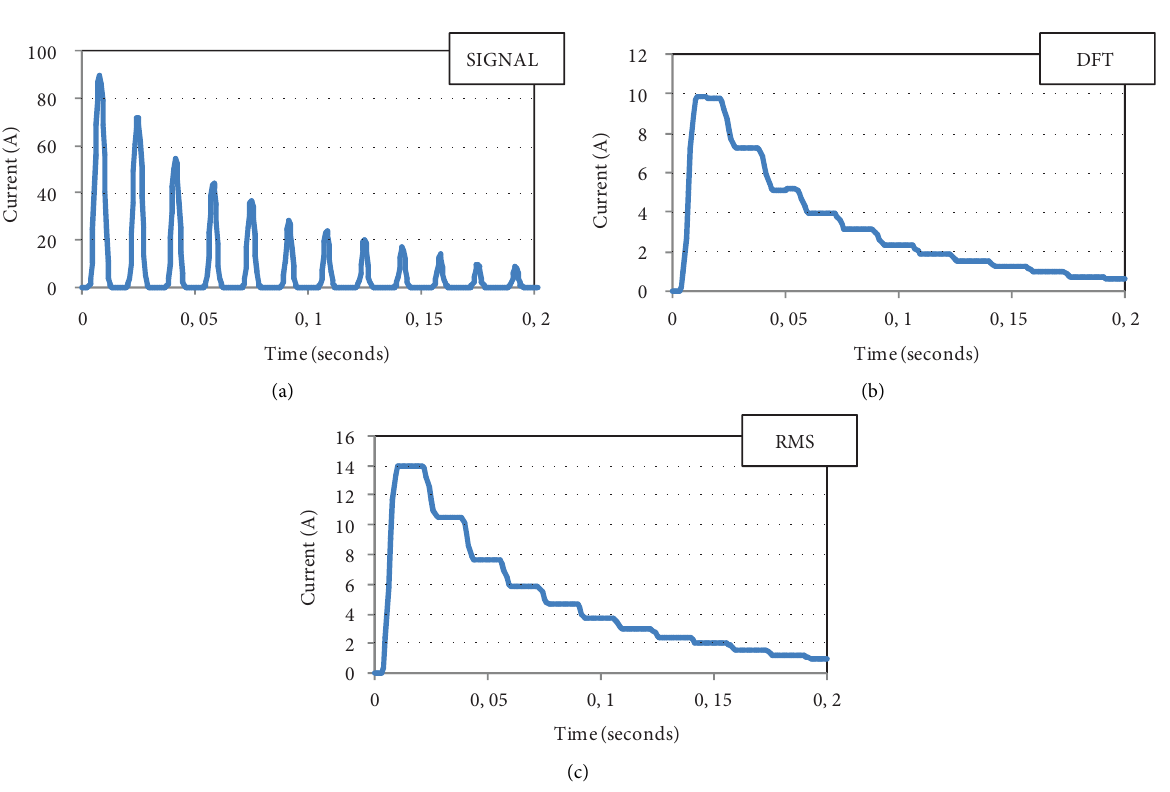
MOD , computed by